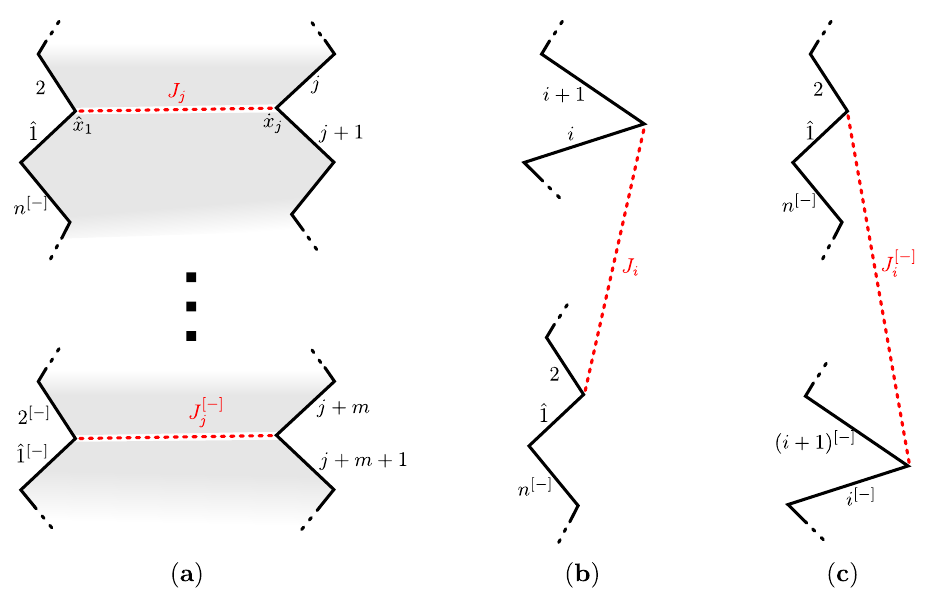
Figure 12 . Factorization poles of the Wilson lines correlator. a) Poles for which the cusp ^ x 1 ( z ) becomes null separated from a cusp on the right Wilson line. b,c) Poles for which the cusp ^ x 1 ( z ) becomes null separated from a cusp on the same Wilson line. That cusp can either be located above ^ x 1 ( z ), (b), or below ^ x 1 ( z ), (c), and the two must lie within one